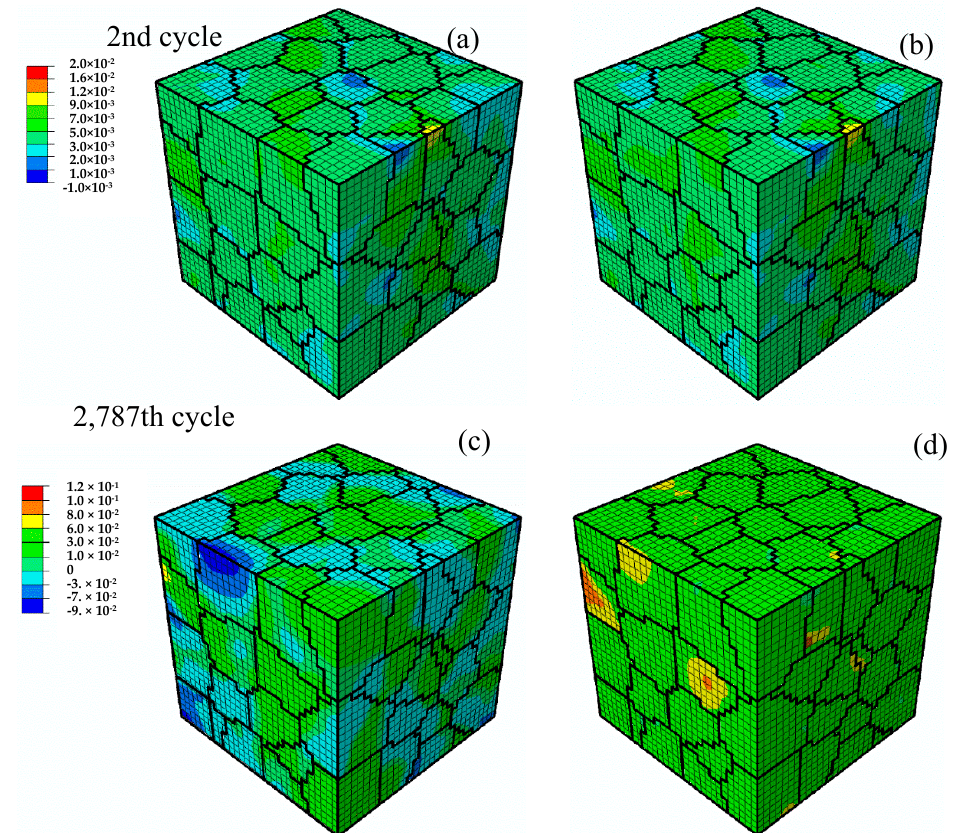
Figure 3. Contours of longitudinal strain, ε ( ll ) , and maximum principal strain, ε I , at the second and 2787th tensile peaks of cyclic loading, respectively, at a strain amplitude E a = 0.004: ( a ) ε ( ll ) at 2nd cycle; ( b ) ε I at 2nd cycle; ( c ) ε ( ll ) at 2787th cycle; ( d ) ε I at 2787th cycle.